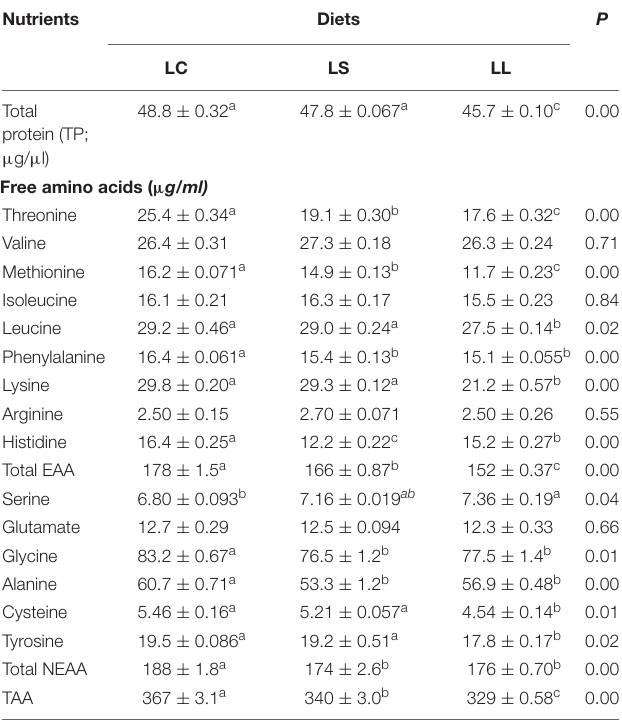
TABLE 5 | Total protein and FAA concentration in the plasma after largemouth bass intake different diets. Nutrients